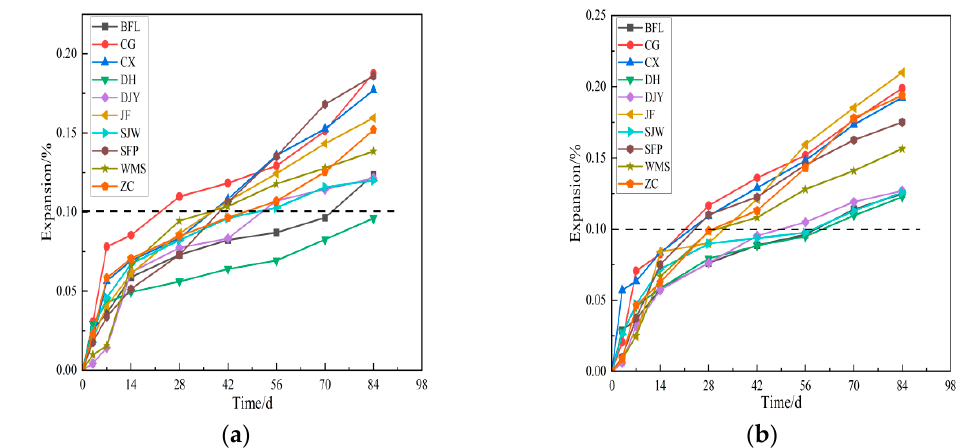
ages. The second stage, samples had obvious expansion as curing ages increase and the differences in expansion began to expand. Final stage, the expansion of most of aggregates appeared slow and tended to be stable. At 42 days, the expansion of BFL, DH, DJY and SJW with 2.5–5 mm particle size at 60 ◦ C were 0.082%, 0.064%, 0.083% and 0.096%, less than 0.1%, but the expansion of DJY and SJW were up to 0.11% and 0.12%, more than 0.1% at Compared with the samples made by 2.5–5 mm aggregates, 5–10 mm samples had bigger expansion, and the expansion of all of samples with 5–10 mm particle size were more than 0.1% at 70 days. In addition to the particle size of aggregates, curing temperature also affects the ex- pansion of samples. Figure 8 shows the expansion of samples prepared by aggregates of 2.5–5 mm and 5–10 mm particle size, cured in 1 mol/L TMAH solution at 80 ◦ C. The expansion data of specimens at 60 ◦ C and 80 ◦ C were analysed, the expansion of most of pared with 2.5–5 mm samples, the differences in the expansion of 5–10 mm samples were DH, DJY and SJW with 2.5–5 mm particle size cured at 80 ◦ C were 0.087%, 0.097%, 0.099% and 0.075%, respectively, were less than 0.1%, and tended to be stable. The expansions of them were greater than 0.1% cured at 84 days curing age.